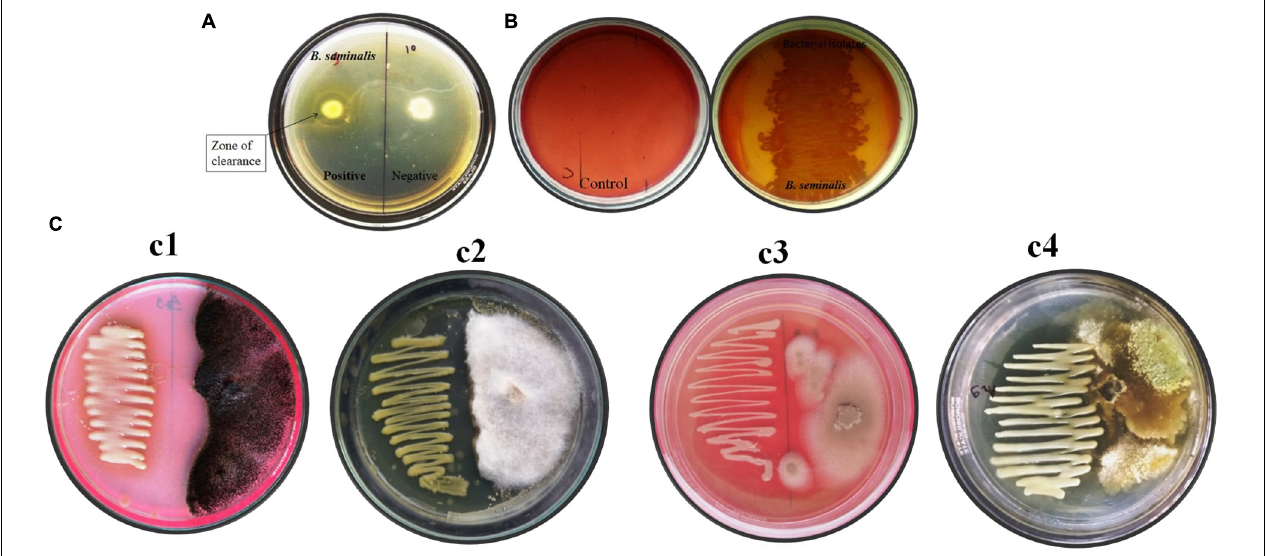
FIGURE 1 | In vitro assay of enzymatic and antifungal activity exhibited by B. seminalis JRBHU6. (A) Chitinase activity (B) Cellulase activity (C) Antifungal activity against different fungus (Cl- Aspergillus niger, C2 -Fusarium oxysporum-, C3 -Microsporum gypseum, and C4- Trichoderma harzianum